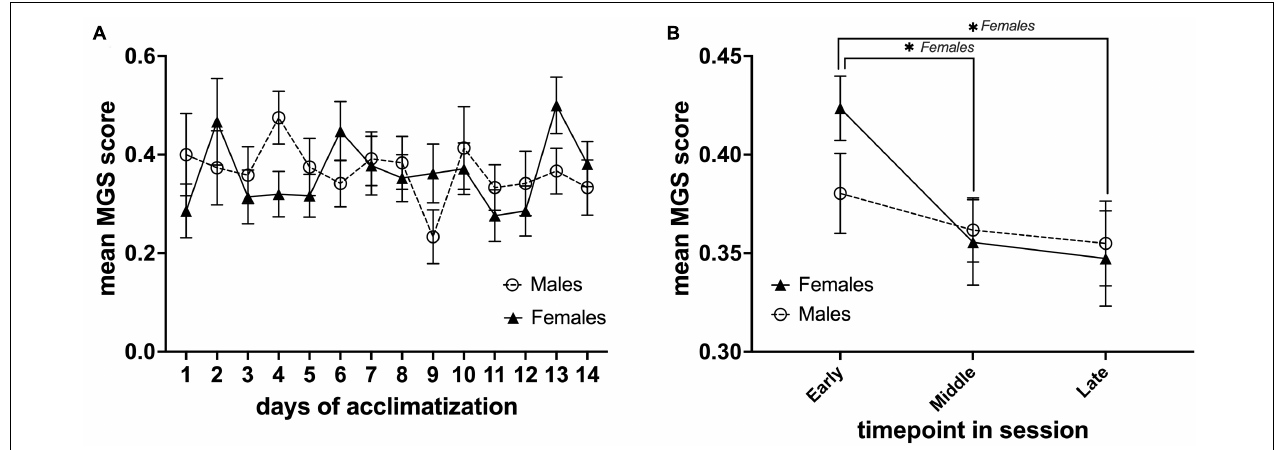
FIGURE 3 | Daily mean MGS score during the awake MRI habituation period and within each MRI habituation session for male ( n = 8) and female ( n = 7) mice. (A) Mean MGS score for each sex of the different days. (B) Mean MGS score for each sex at the early, middle, and late time points within all sessions (14 days). Data are presented as mean ±